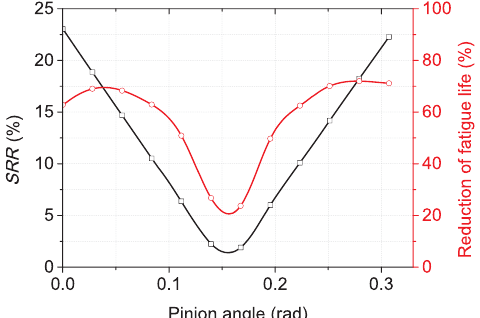
Fig. 15 Variations of SRR and reduction of fatigue life in a mesh cycle. Table 4 Qualitative comparison between simulations and available experimental data in literature. Item